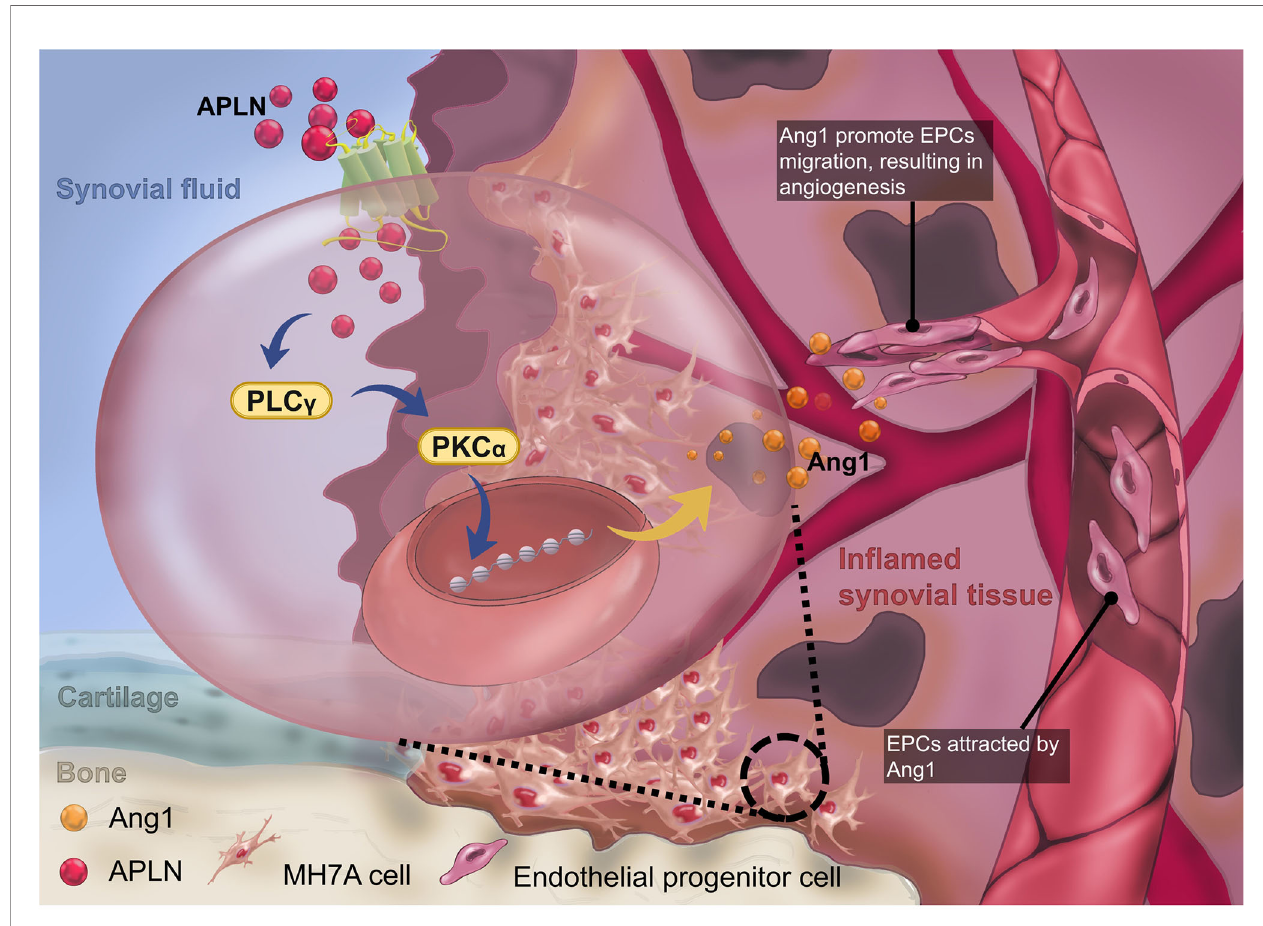
FIGURE 7 | The schematic diagram summarizes the mechanisms of APLN-induced Ang1-dependent EPC angiogenesis during RA pathogenesis. APLN induces Ang1 expression in RASFs by suppressing miR-525-5p expression via the PLC g and PKC a signaling pathways, and promotes EPC angiogenesis in